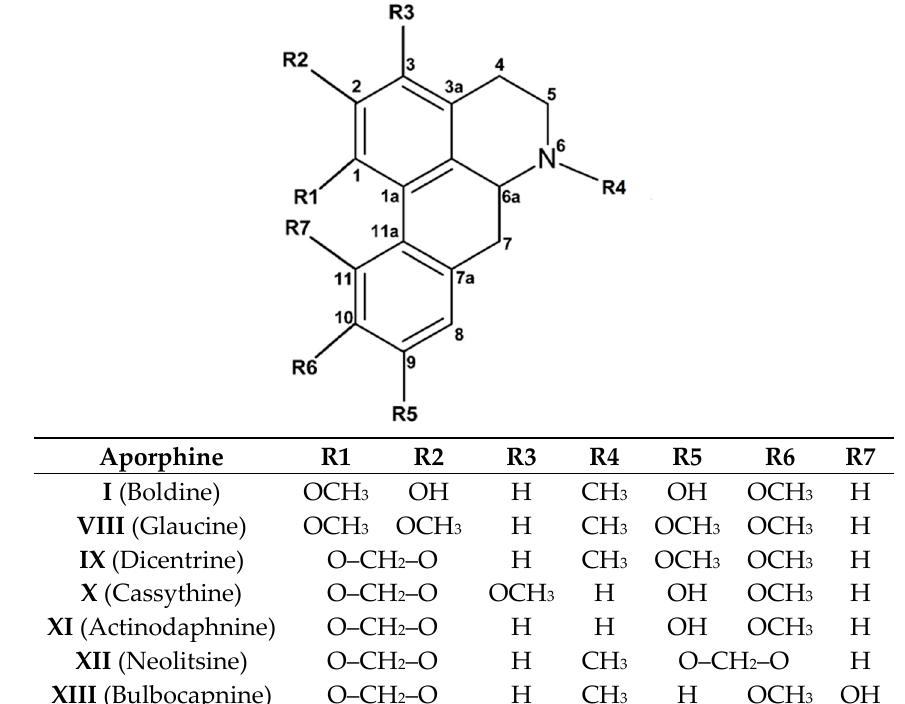
Figure 6. Derivatives molecules of boldine measured in cytotoxic and DNA interaction assays .